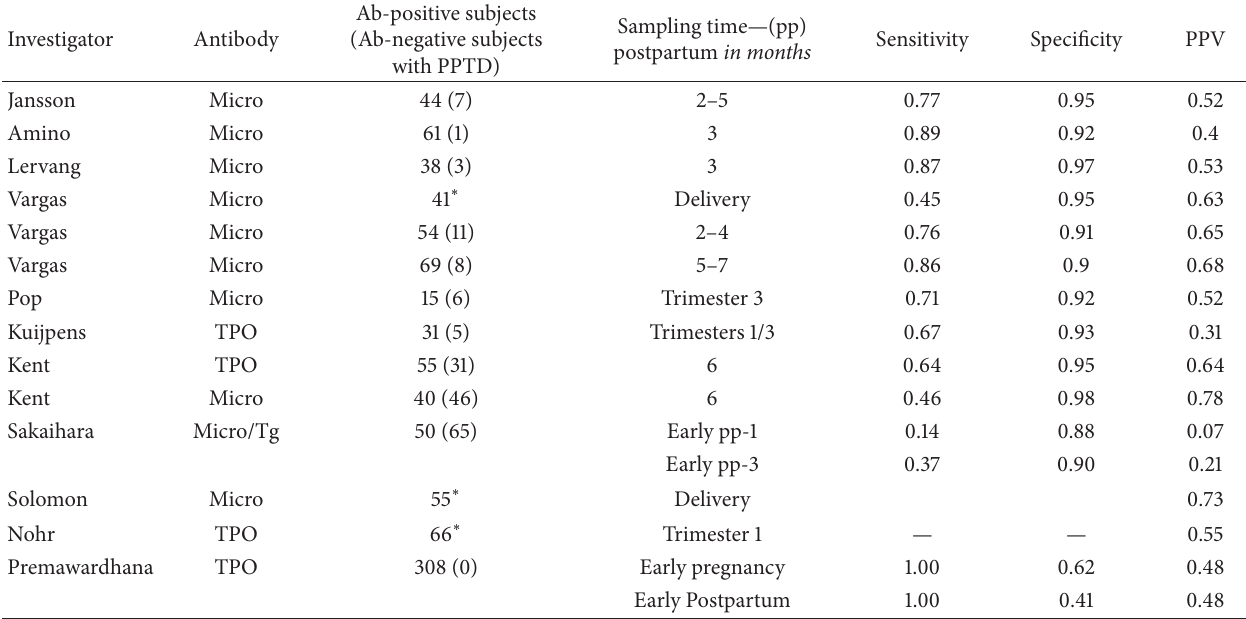
Table 3: Sensitivity, specificity, and positive predictive values of thyroid autoantibodies when sampling done at the different times in pregnancy and post-partum adapted from Premawardhana et al. The positive predictive value of thyroid antibodies in predictive post-partum thyroid disease